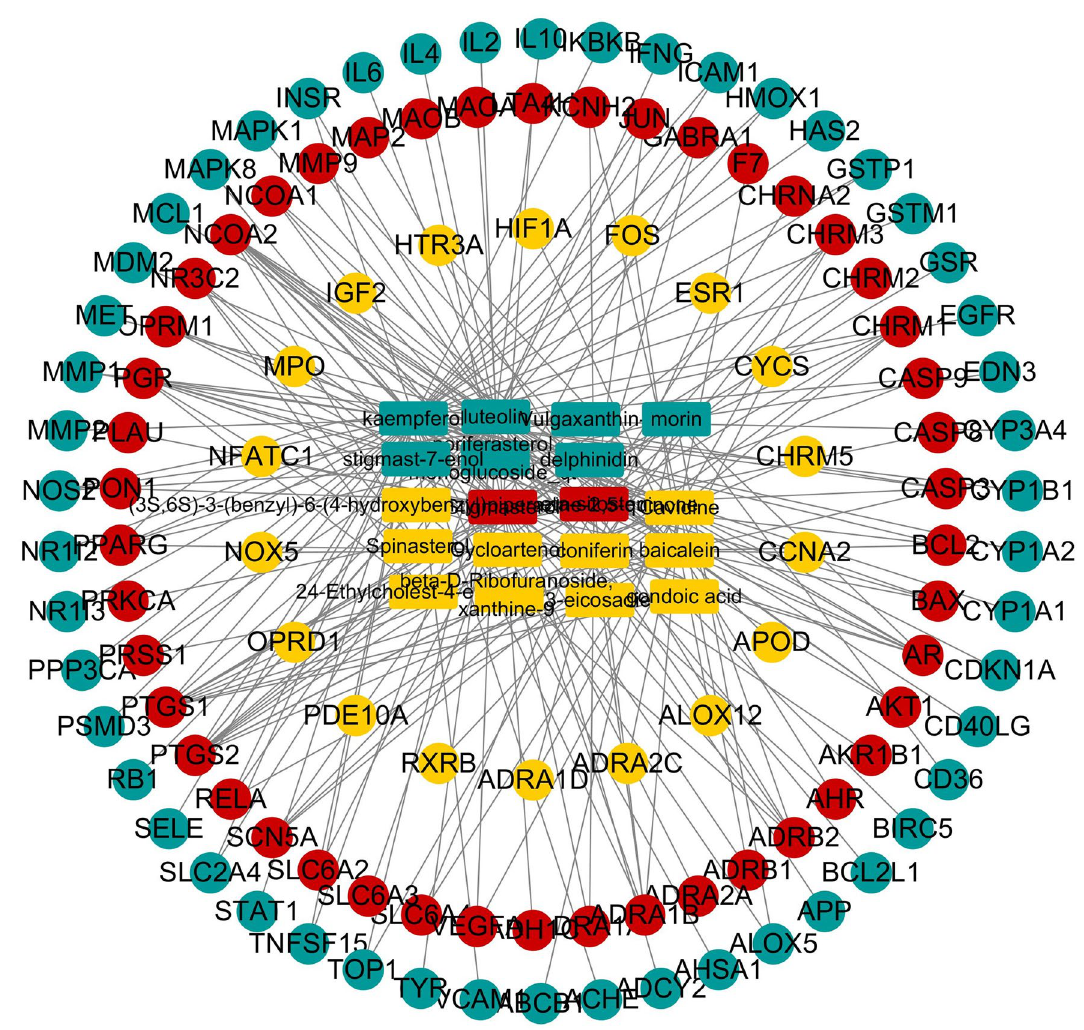
Figure 5. Compound-target network constructed by linking candidate compounds of Banxia-Xiakucao Chinese Herb Pair with their potential targets. In total, 19 candidate compounds of Banxia-Xiakucao Chinese Herb Pair [yellow rectangle, Pinellia ternate (Banxia); blue rectangle, Prunella vulgaris (Xiakucao); red rectangle, Pinellia ternate (Banxia) and Prunella vulgaris (Xiakucao)] were connected to 114 putative sleep disorder-related targets [yellow circles, Pinellia ternate (Banxia); blue circles, Prunella vulgaris (Xiakucao); red circles, Pinellia ternate (Banxia) and Prunella vulgaris